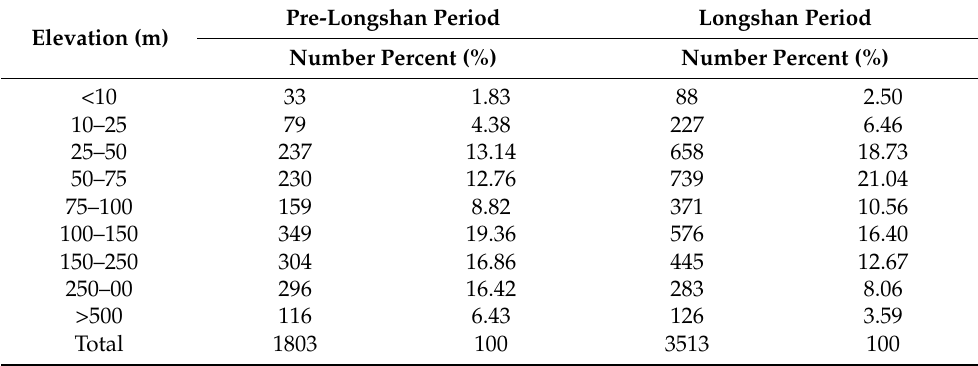
Table 2. The elevation distribution of archaeological sites in the lower Yellow River floodplain and the surrounding areas during the pre-Longshan and Longshan